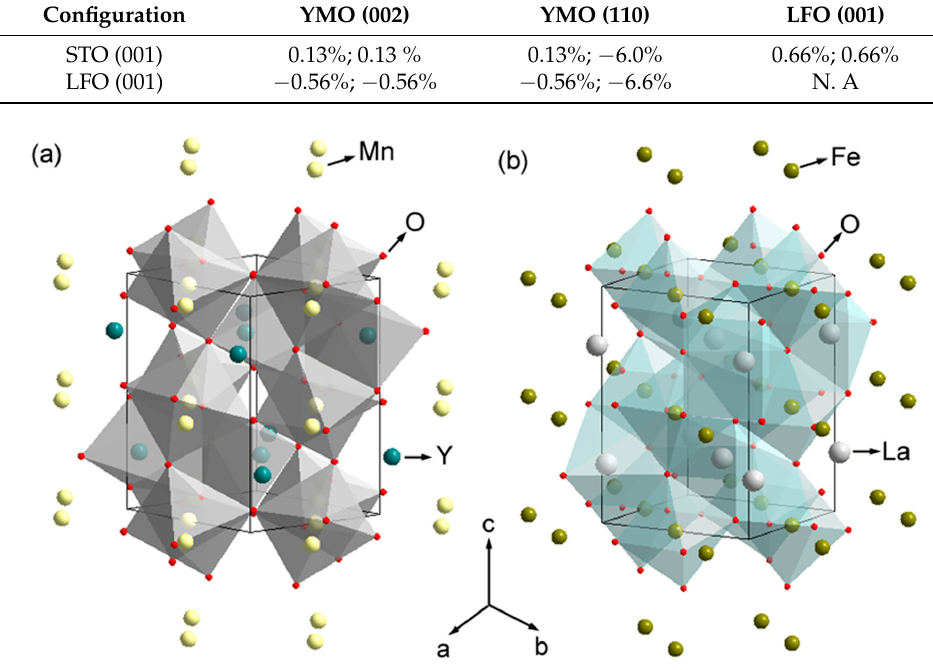
Figure 10. ( a , b ) are atomic structures of YMO and LFO, respectively. One can see the greater distortion of oxygen octahedra in YMO with respect to LFO.